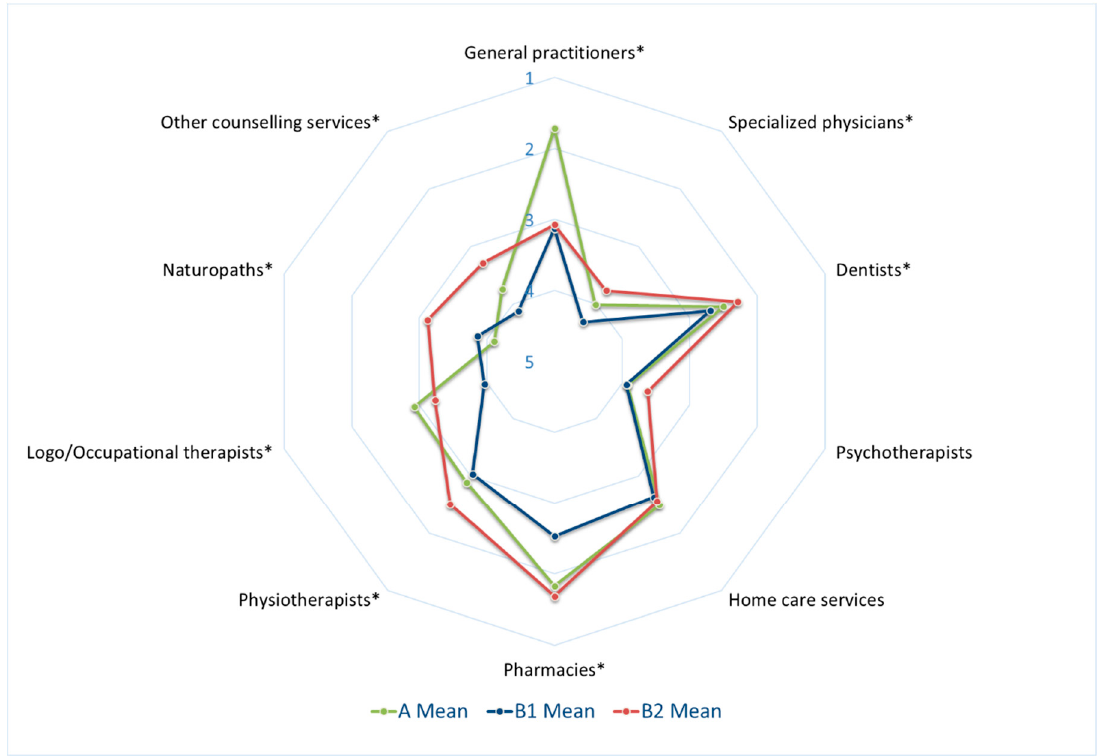
Figure 1. Perception of different healthcare structures by region/community. Average ratings of community A are displayed in green, those of Regions B1 and B2 in blue and red, respectively. Presented are means of scales. Study participants were asked “How do you rate healthcare services offered by …?”) and rated their answers from 1 = very good to 5 = very poor (*Significant statistical difference between groups ( p < 0.05), assessed using Kruskal–Wallis test.